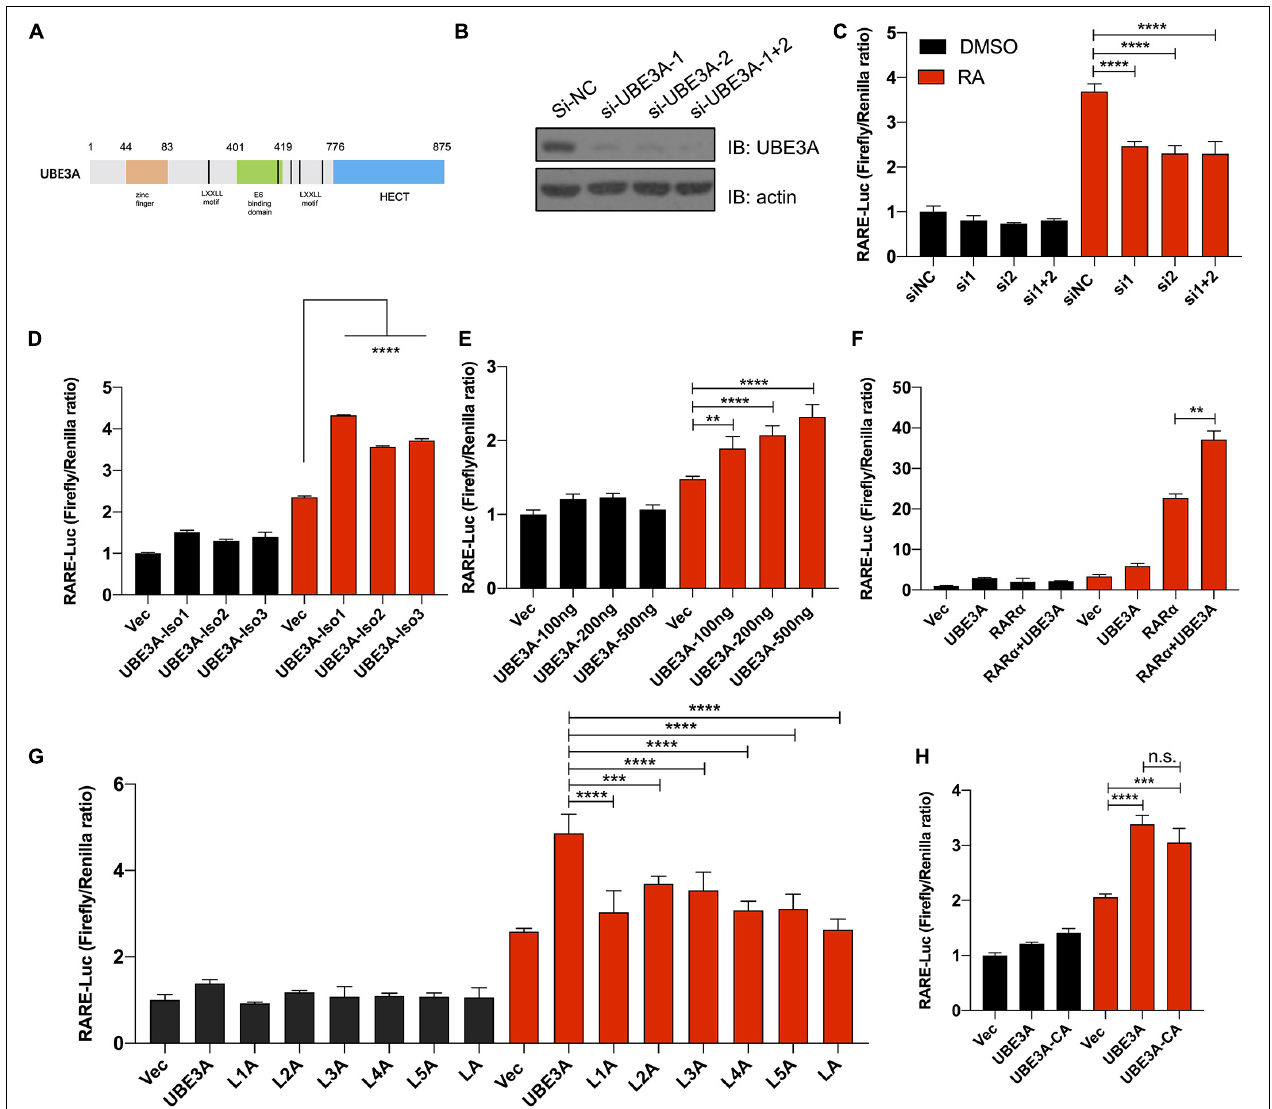
FIGURE 2 | UBE3A acts as a coactivator regulating RARE-luciferase expression. (A) Schematic structure of UBE3A protein. UBE3A is an 862-amino acid protein that mainly includes five LxxLL domains, a zinc finger domain and a HECT domain. (B) Endogenous UBE3A protein was knocked down upon siRNA treatment. siRNA-UBE3A1, siRNA-UBE3A2 and negative control were transfected into H1299 lung cancer cells, and the protein expression of UBE3A was assessed by western blotting. (C) UBE3A knockdown decreased luciferase activities. H1299 cells were transfected with siUBE3As (the indicated siRNA sequences are listed in Supplementary Table 5 ), and RARE luciferase activities were tested after stimulation with 1 µ M ATRA for 8 h. (D) All isoforms of UBE3A showed activation of RARE-luciferase activities. H1299-KO-UBE3A cells were transfected with vector or different isoforms of UBE3A and then treated with 1 µ M ATRA for 8 h. (E) UBE3A could activate luciferase activities in a dose-dependent manner. SH-SY5Y cells were transfected with the indicated dosages of UBE3A followed by 1 µ M ATRA treatment for 8 h, and the luciferase ratios were detected. (F) UBE3A and RAR α showed coactivation of RARE-luciferase activities. H1299-KO-UBE3A cells were transfected with vector, UBE3A, RAR α or UBE3A + RAR α and then treated with 1 µ M ATRA for 8 h. (G) Mutant in the LxxLL domain compromised the activation of UBE3A. H1299-KO-UBE3A cells were transfected with the indicated LxxLL mutation (L1A or L2A or L3A or L4A or L5A or LA, labelled in method 2.2) followed by 1 µ M ATRA treatment for 8 h. (H) The ligase mutant C843A mutant did not affect luciferase activity. Wild-type UBE3A and ligase mutants were overexpressed in H1299-KO-UBE3A cell lines followed by 1 µ M ATRA treatment for 8 h. The normalized luciferase activities represent ratios of firefly to Renilla values. The values are expressed as the means ± SEM from at least three independent repetitions. * P < 0.05, ** P < 0.01 , *** P < 0.001 , **** P < 0.0001 . (C–H) one-way ANOVA with Bonferroni post hoc